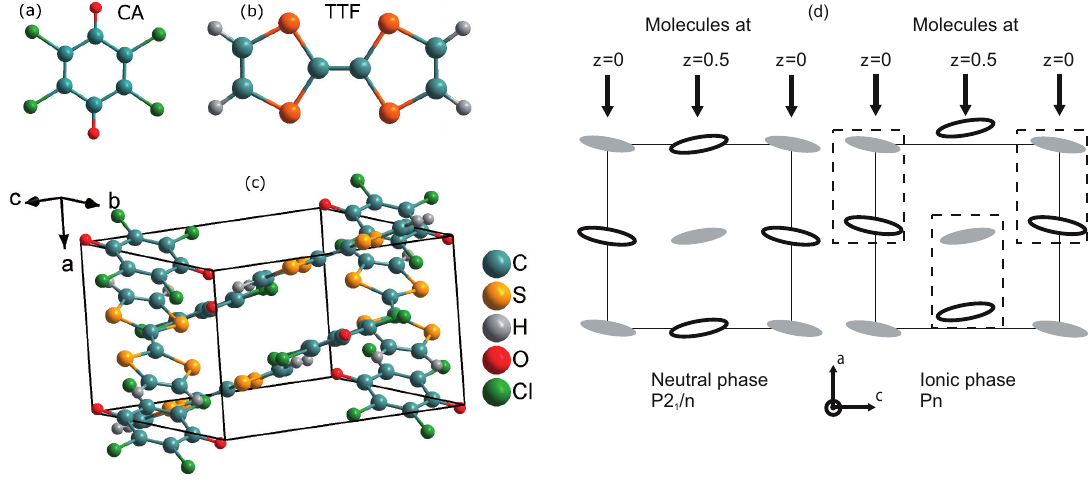
Figure 1. ( a ) Chloranil molecule (CA, C 6 Cl 4 O 2 , color of the material: yellow); ( b ) Tetrathiafulvalene (TTF, C 6 S 4 H 4 , color of the solid: orange); ( c ) Monoclinic unit cell of TTF-CA at room temperature. The TTF and CA molecules are ordered along the crystallographic a -axis [2]. Due to the crystal symmetry and the position of the molecules, a unit cell contains two equivalent TTF and CA molecules; ( d ) At room temperature, the space group of the unit cell is P2 1 /n and the CA and TTF molecules are stacked equally spaced along the a -axis. A further stack is located at z = c = 0.5, respectively, at which the TTF-CA pairs are tilted opposite to the a -axis. Lower right: in the ionic phase, the TTF and CA molecules dimerize along the a -direction. By the charge transfer of about ρ = 0.6 e , electric dipoles are formed along the stacking direction, resulting in a loss of the two-fold screw axis 2 1